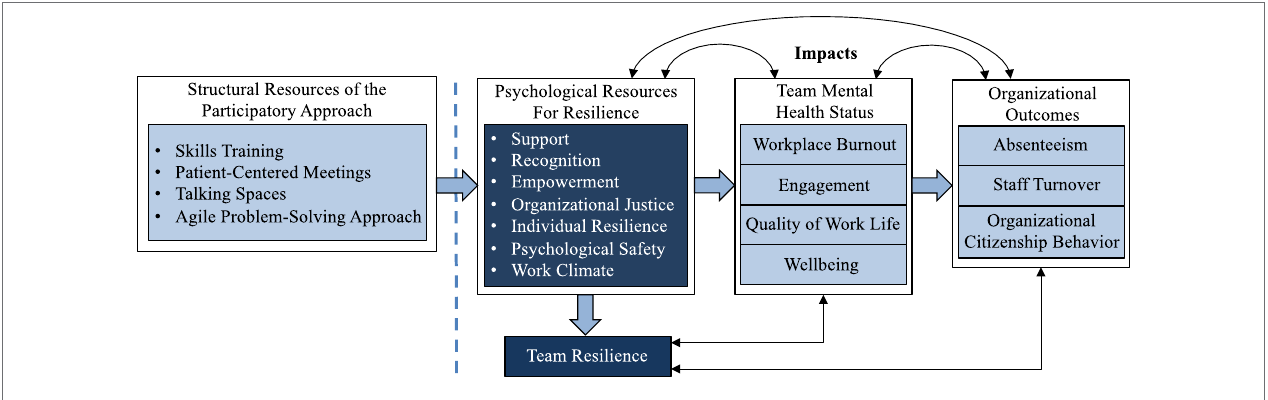
FIGURE 1 | The proposed integrative organizational